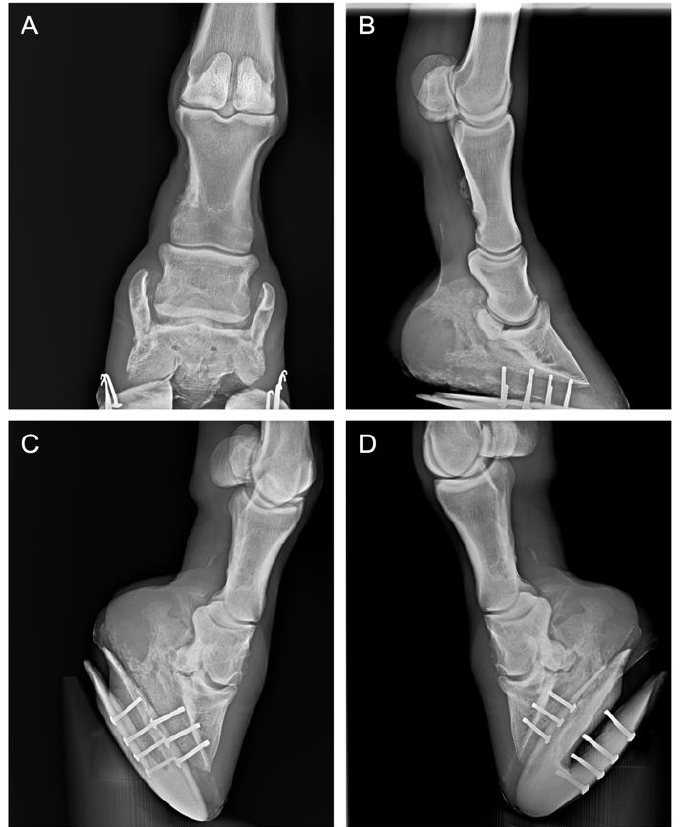
Figure 2. Case 2: X-ray of the right forelimb lateromedial, dorso-palmar, dorsoproximal– plantarodistal oblique, and plantaroproximal-plantarodistal oblique views ( A – D ) respectively revealed bone remodeling of the distal interphalangeal joint of the affected limb, periarticular osteophytes, and ossification of the collateral cartilage (sidebone), accompanied by alterations in the silhouette of the navicular bone.